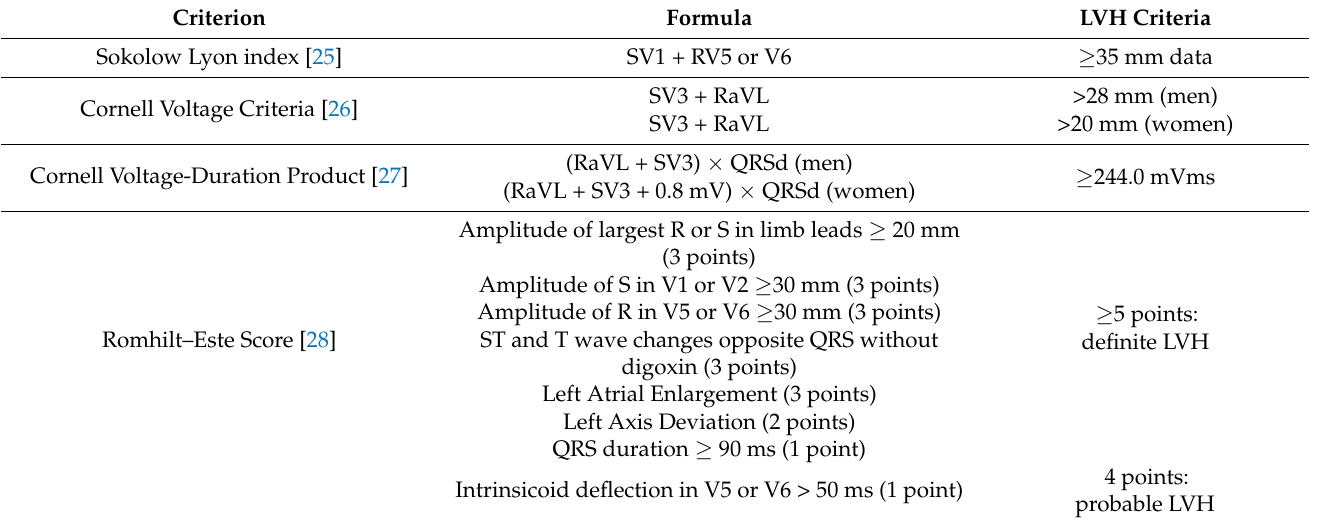
Table 1. The most commonly used ECG criteria for left ventricular